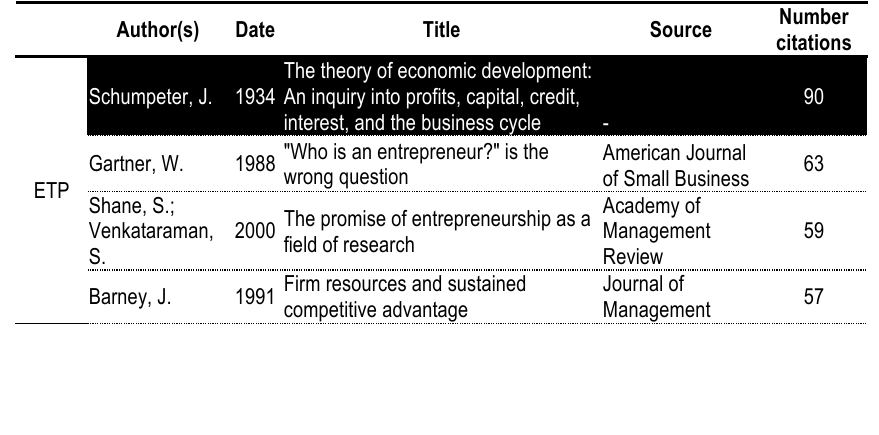
Table 5. Ranking of the Top 10 most-cited studies in ETP, JBV and